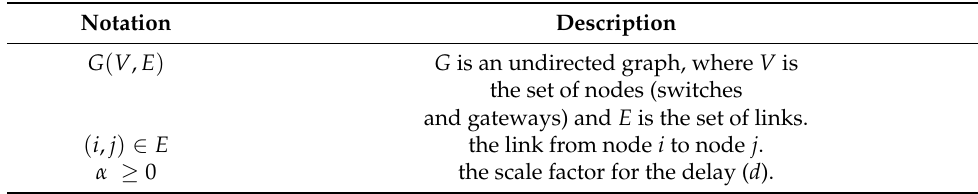
Table 2. Summary of key